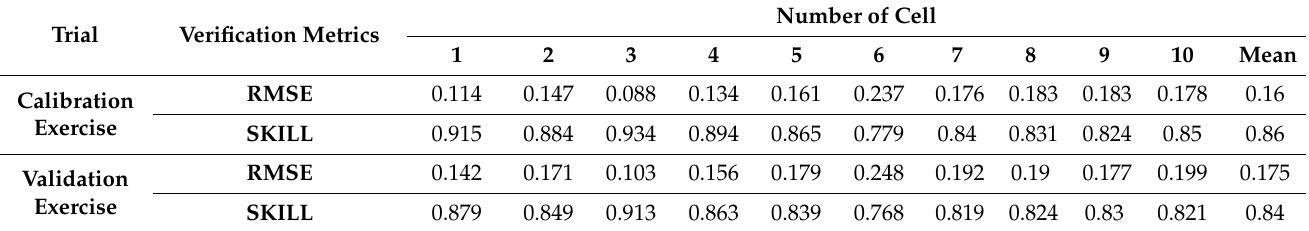
Figure 5. The calibration exercise compares the simulated (orange line) and observed (blue line) flow velocity from 06:00 to 23:59 on 5 January 2022. Table 2. The RMSE and SKILL values of the calibration and validation exercises of the TELEMAC-3D model.